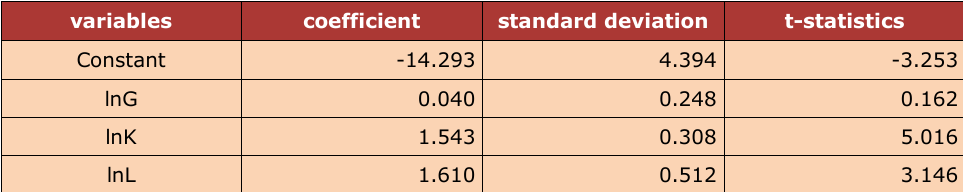
So, the regression equation is LnY=-14.293+0.0403*lnG +1.543*lnK+1.610*lnL (Adjust R2 =0.988,